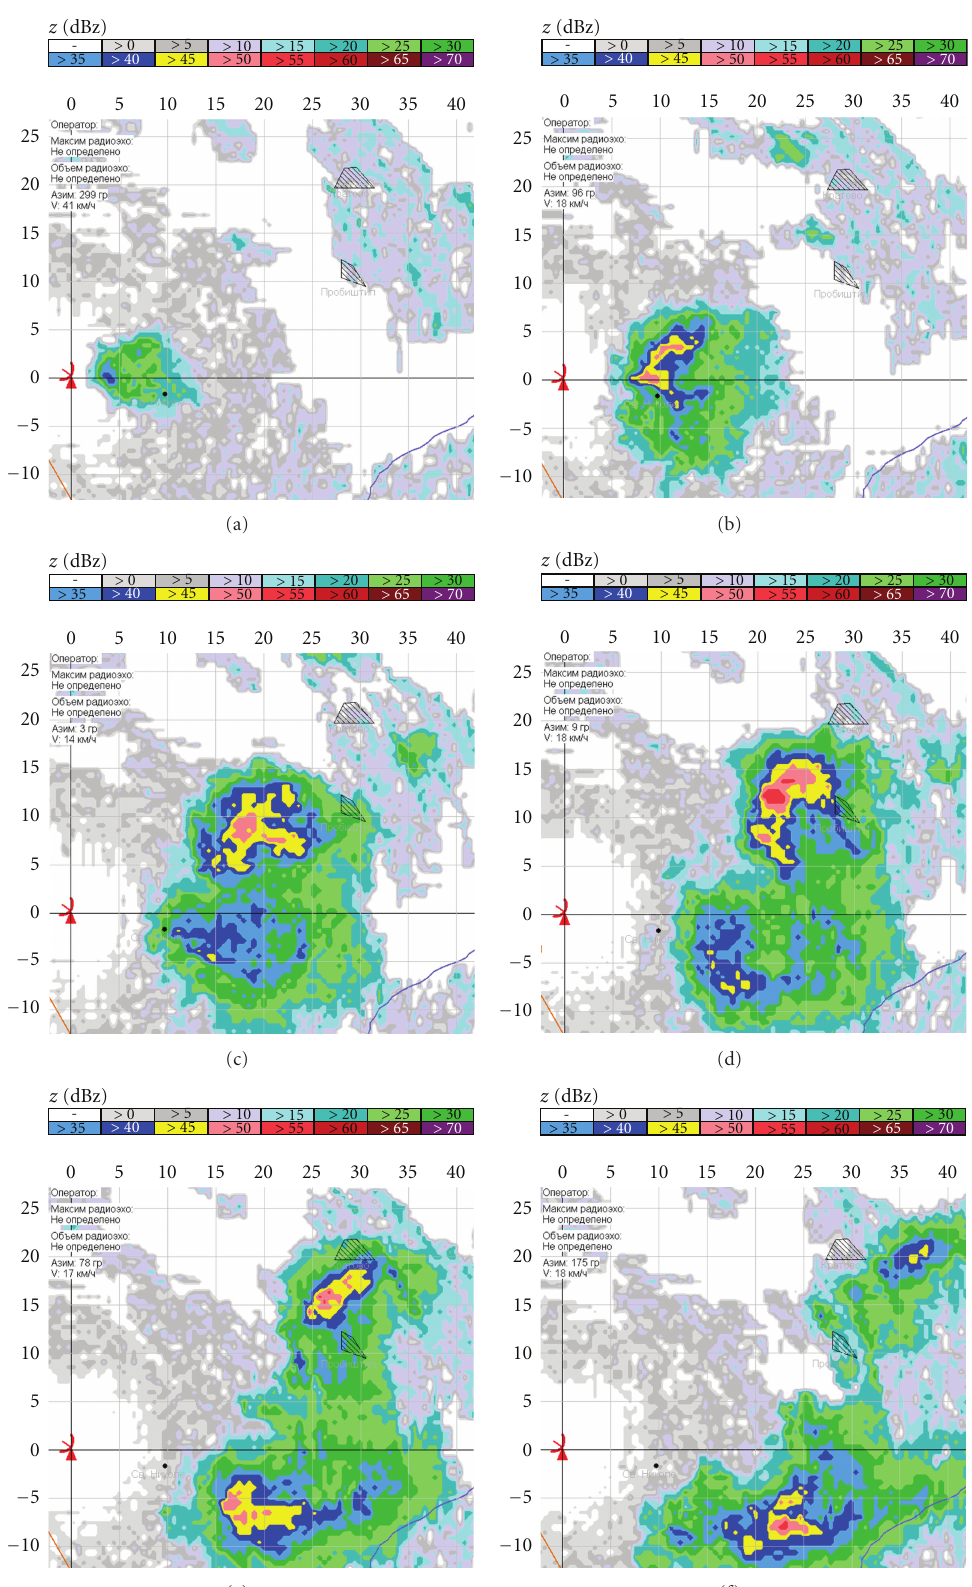
Figure 7: Radar reflectivity (dBZ) at z = 6 . 5 kmm.s.l. Observations provided from WSR-74 S/X radar upgraded with ASU-MRL, at di ff erent time intervals, starting at 15:37